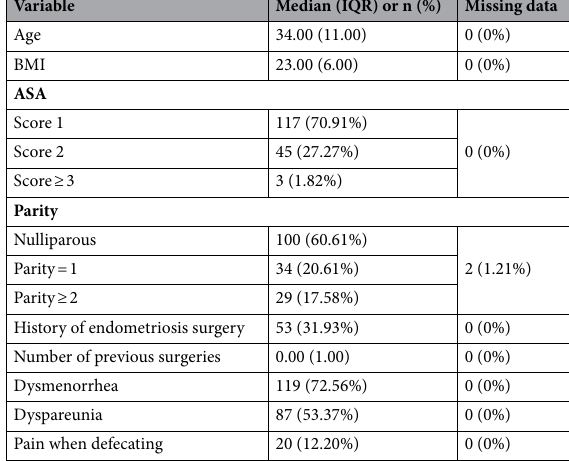
Table 1. Demographic characteristics of the study